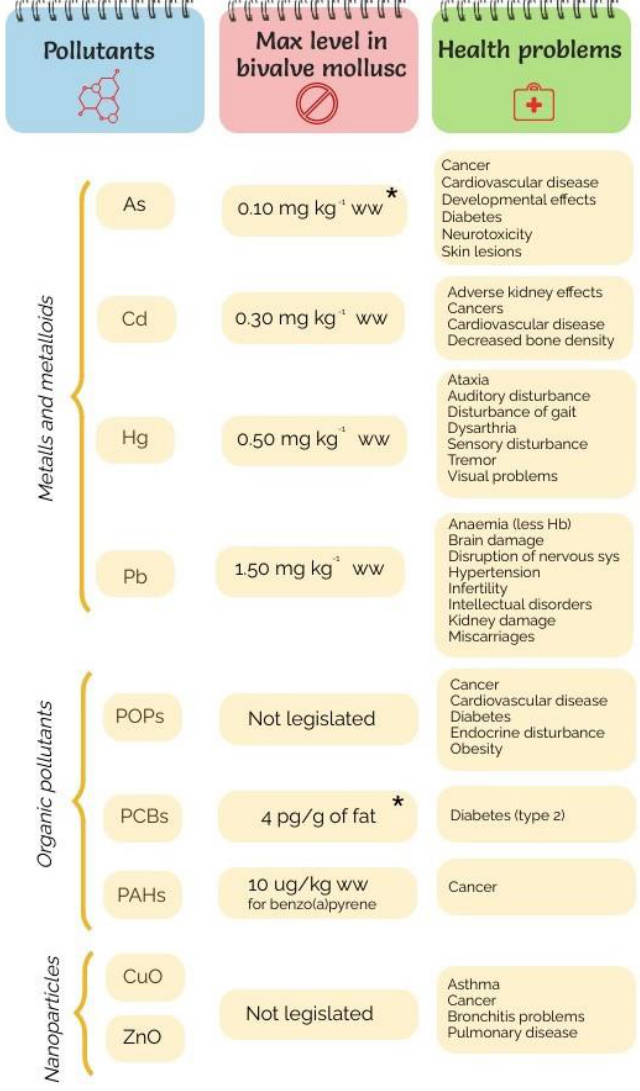
Figure 4. Main health problems caused by marine pollutants pose a major threat to sustainable aquaculture and food safety. The maximum permitted levels in bivalve molluscs (except for PCBs, which is in fishery products as indicated by *) are regulated by European Commission (EC) No 1881/2006 of 2006. The maximum level of arsenic in foodstuffs is according to CODEX, S. (1995). As is a metalloid that mainly arises from anthropogenic sources since it can be used as a color agent in textile manufacturing, insecticide or rodent killer. Water and food